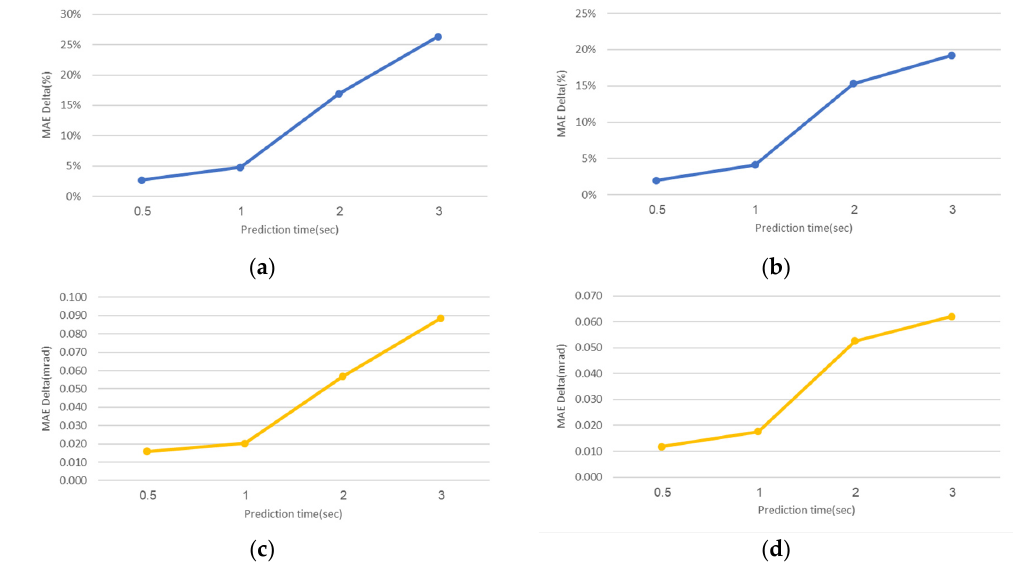
Figure 5. Narrow range delta error values using XGBoost CA vs. classical CA in various prediction times. ( a ) Roll error delta (%); ( b ) Pitch error delta (%); ( c ) Roll error delta (mrad); ( d ) Pitch error delta (mrad).